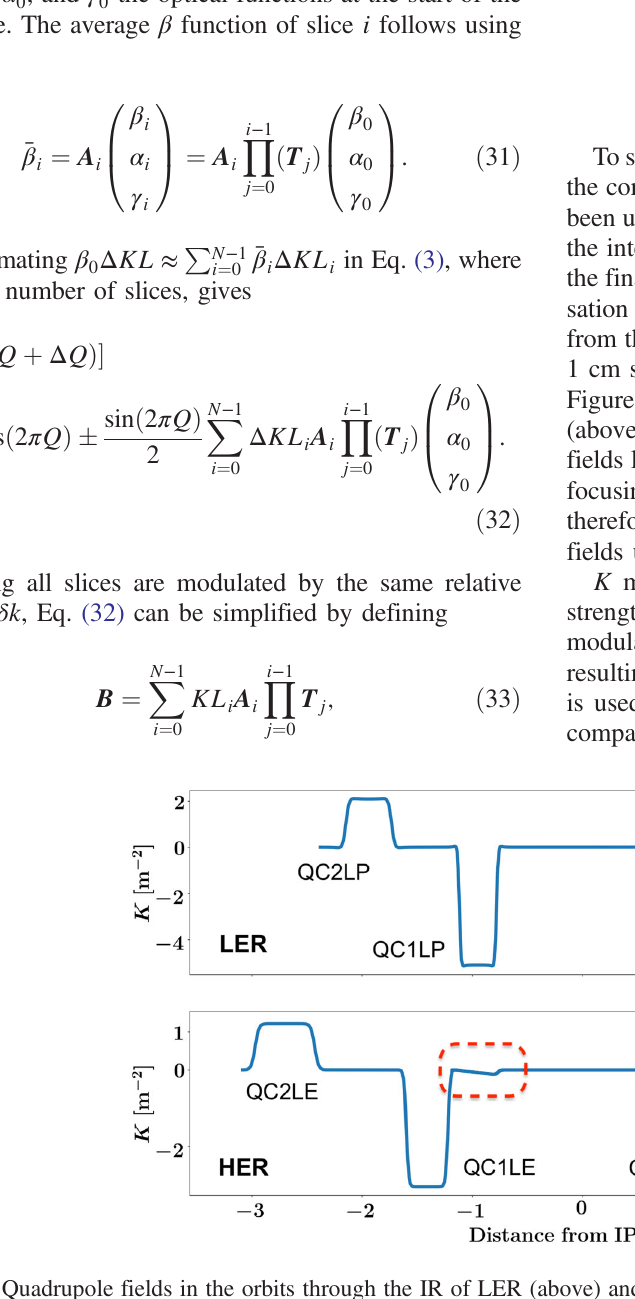
FIG. 5. Quadrupole fields in the orbits through the IR of LER (above) and HER (below). The names of the magnets are indicated. Fields from the inner quadrupoles in LER that leak into the HER orbit are pointed out with red rectangles. The focusing system is nearly symmetric, but notice slightly different lengths and placements of horizontally focusing magnets in